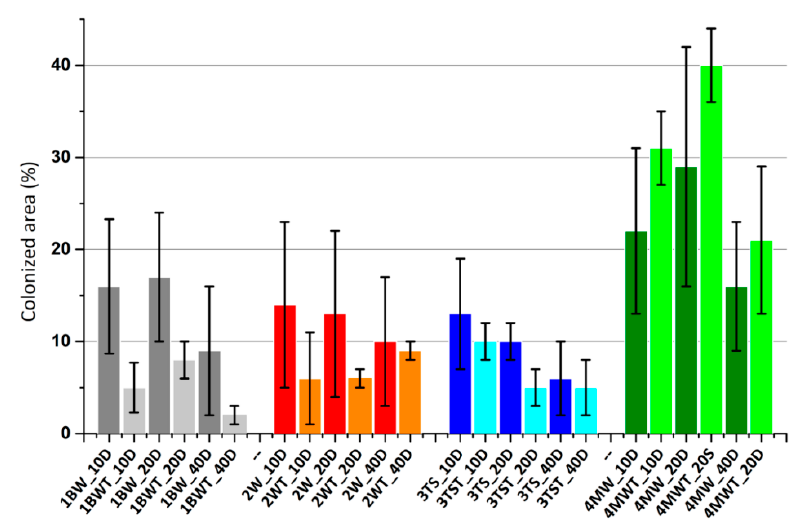
Figure 6. Average percentage and standard deviation of tile surface (%) colonized by the fungus Cladosporium sp. on non-treated ( n = 3, darker color) and TiO 2 -treated ( n = 3, lighter color) tiles obtained by digital image analysis after 10-, 20- and 40-days incubation.